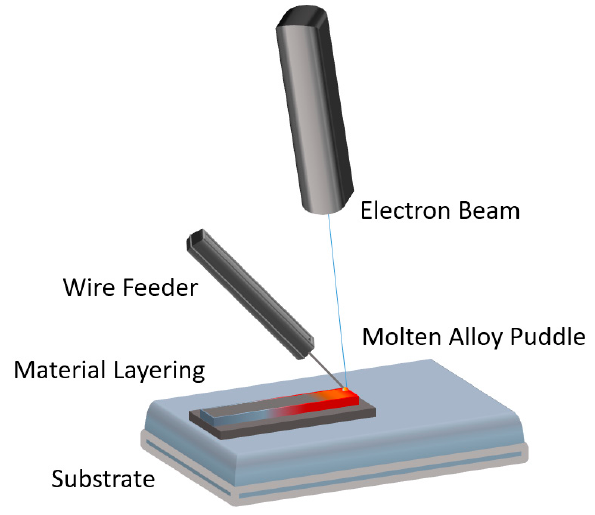
Figure 8. A general schematic of wire-fed system.